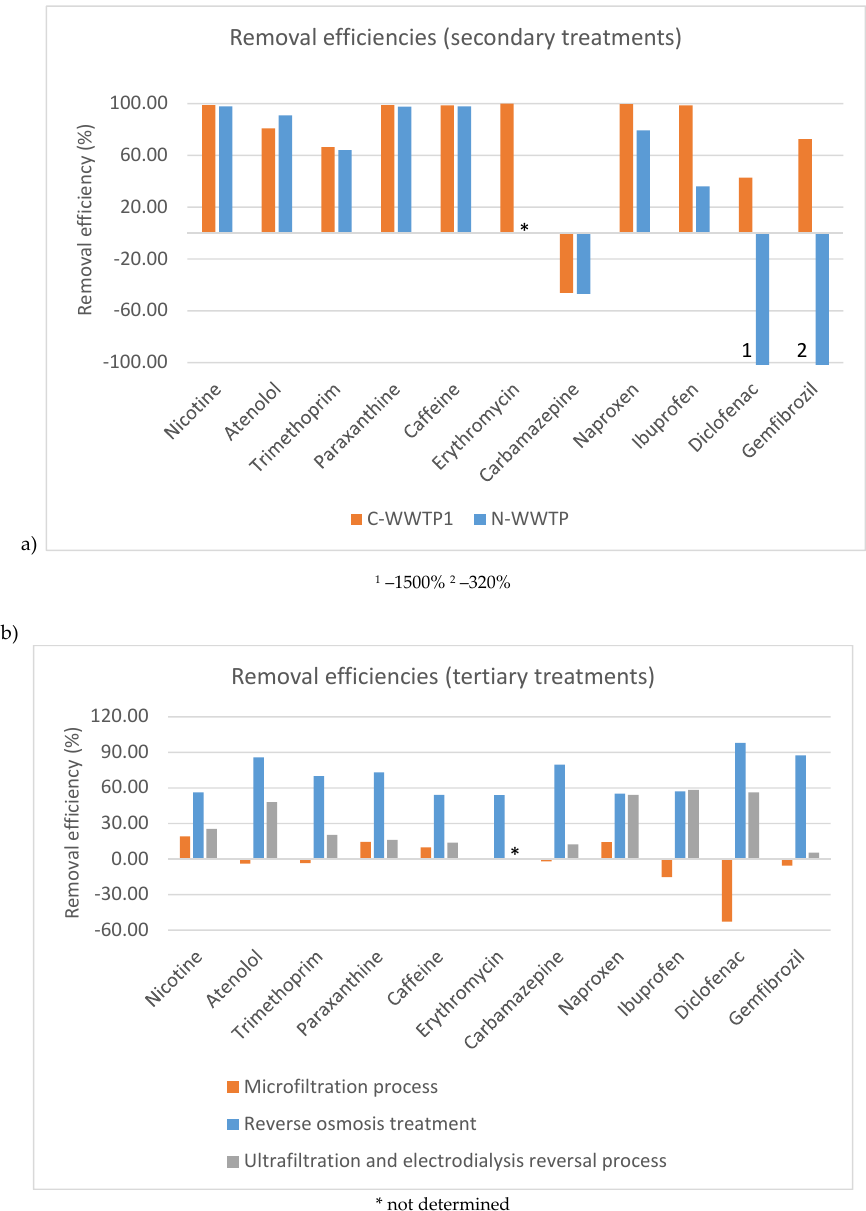
Figure 3. Median removal e ffi ciencies for target compounds using ( a ) secondary treatments and ( b ) tertiary